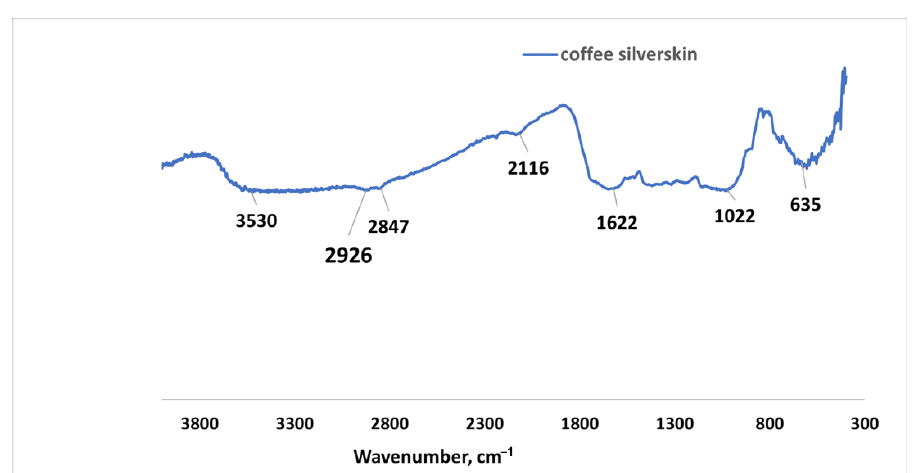
Figure 3. FTIR spectra for raw coffee silverskin